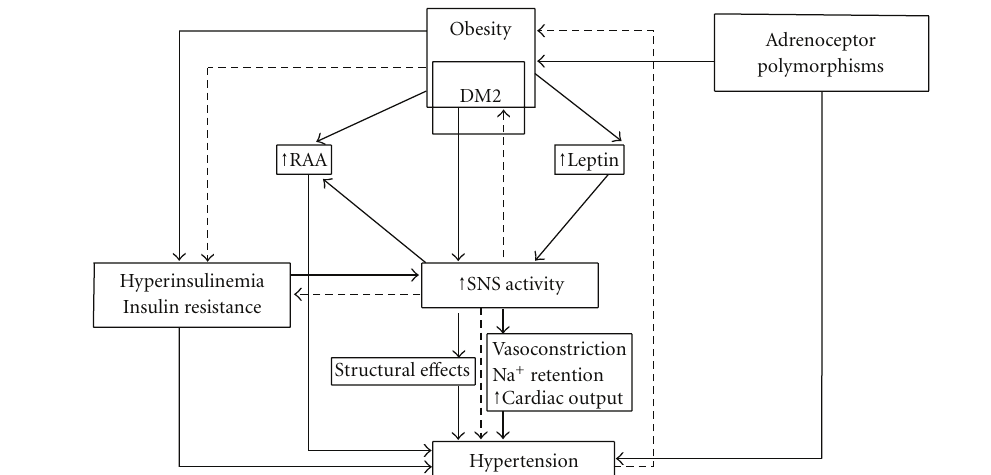
Figure 1: Potential pathophysiological mechanisms by which obesity may contribute to hypertension (modified figure from [23]). RAAS: renin-angiotensin-aldosterone system; SNS: sympathetic nervous system; OSA: obstructive sleep apnea; BRS, baroreflex